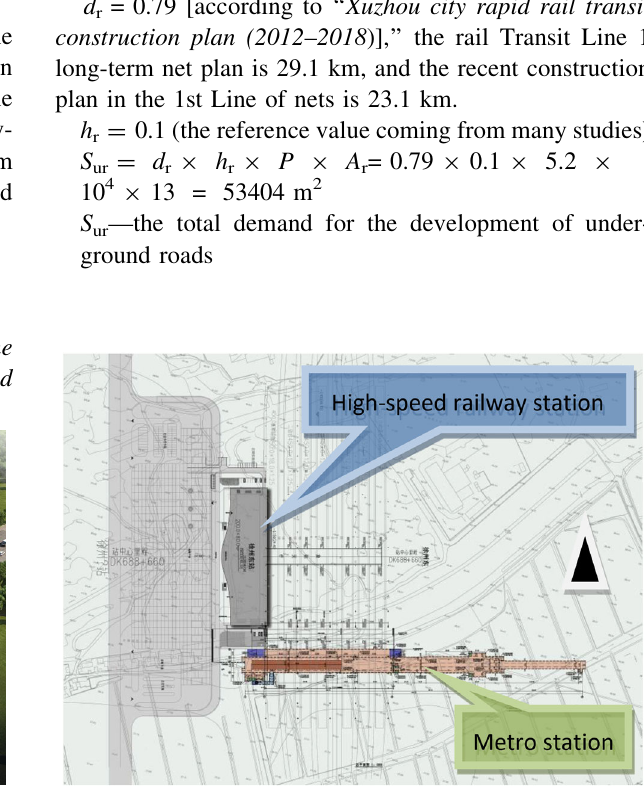
Fig. 4 The neighborhood center of high-speed railway station area Fig. 5 Schematic diagram of high-speed railway